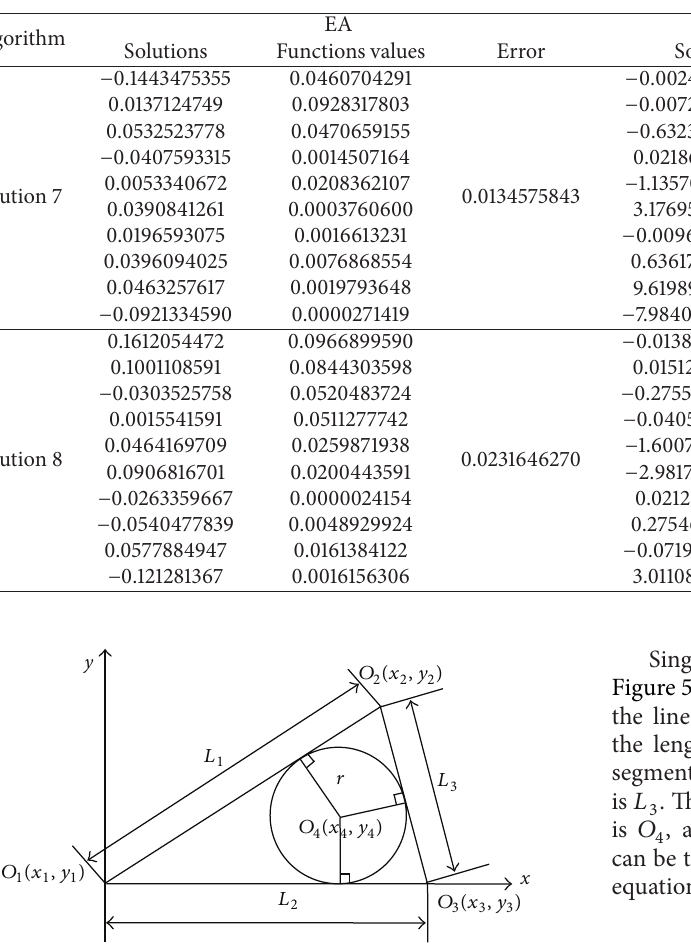
Figure 5: Single circle packing problem